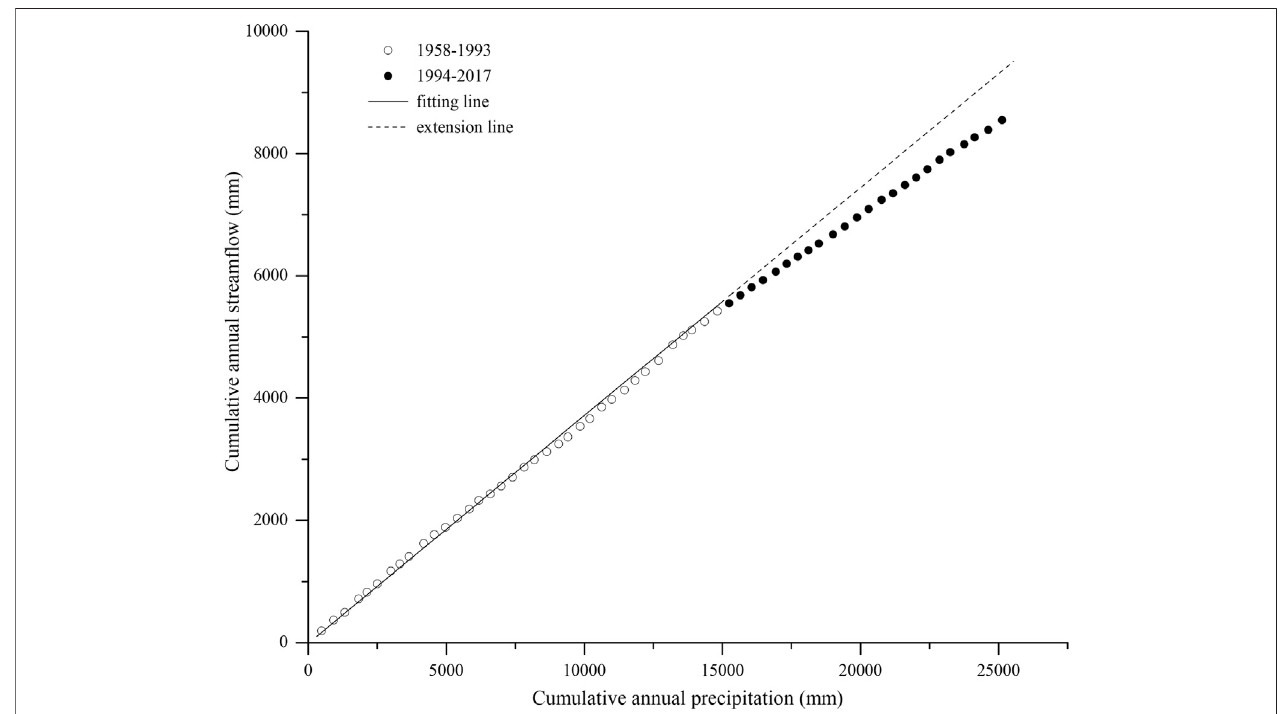
FIGURE 4 | Double mass curve analysis between stream fl ow and precipitation.